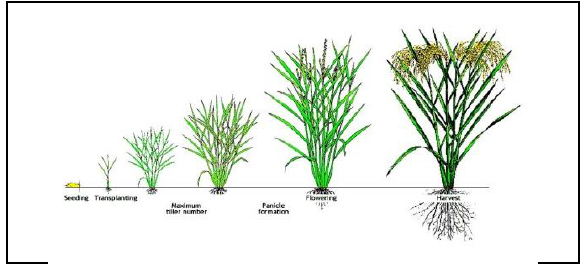
Figure 1. Rice crop stages. Image from the International Rice Research Institute (IRRI)-Rice Knowledge